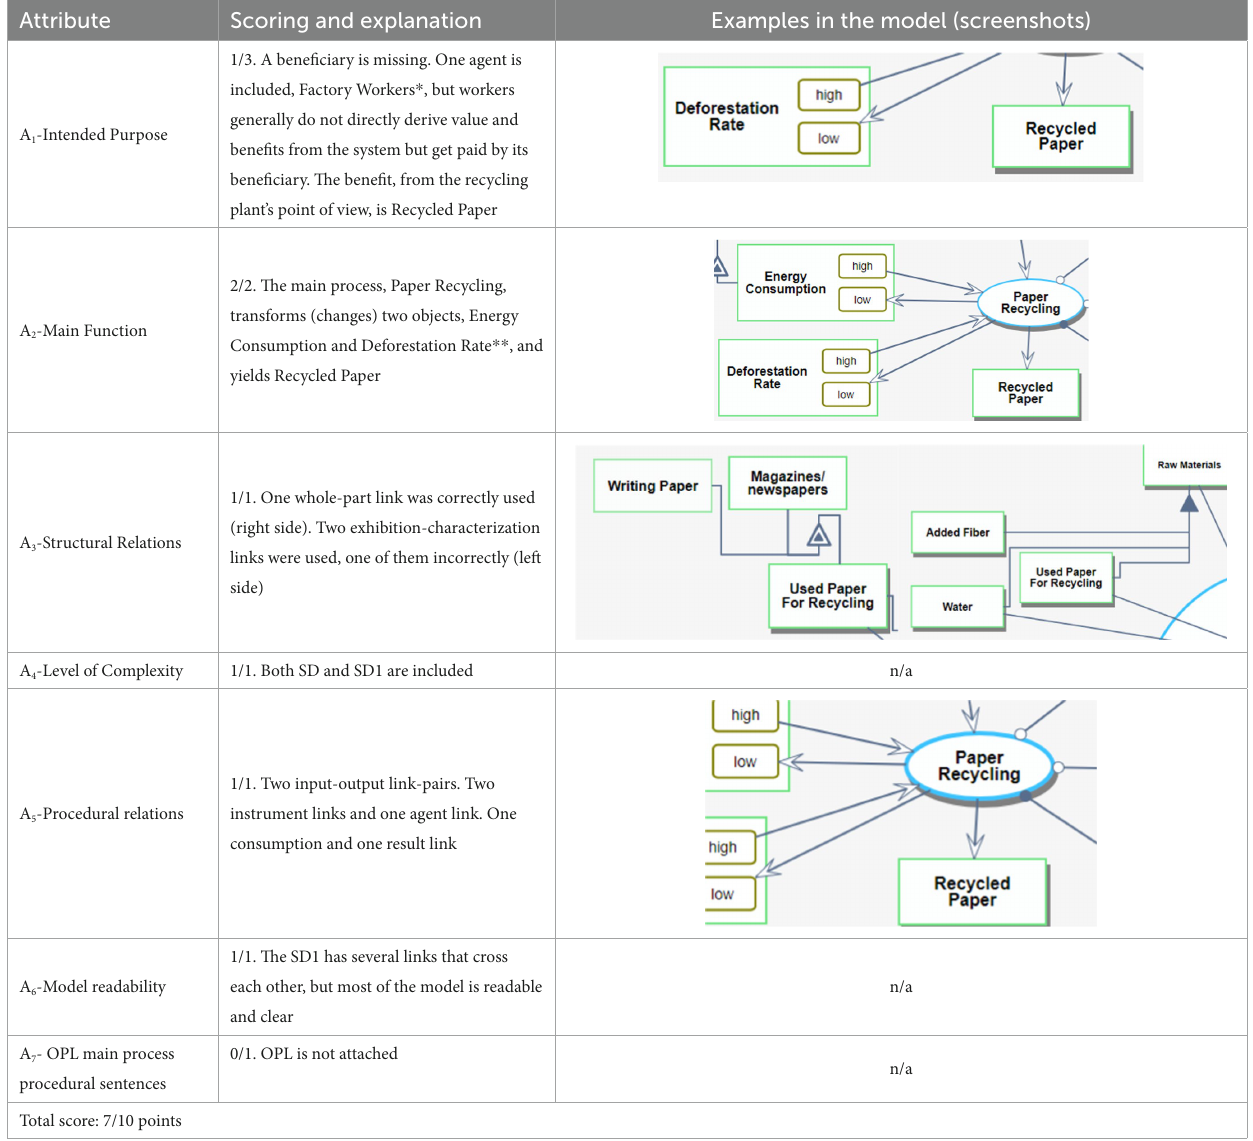
TABLE 8 Scores and explanations for the OPM model created by Ron. Attribute Scoring and explanation Examples in the model